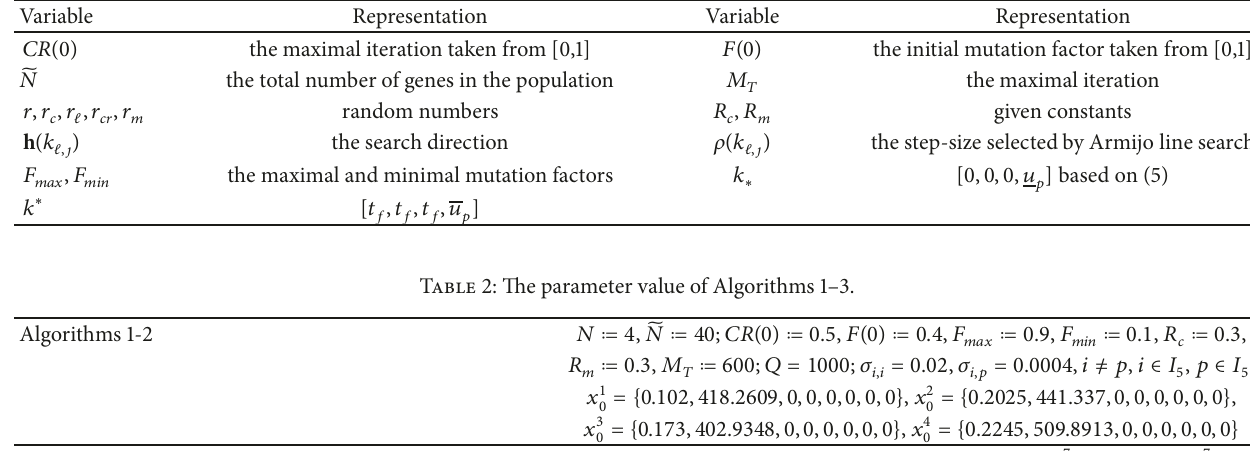
Table 3: The value of 𝑢 𝑖∗ 𝑝 , 𝜃 𝑖∗ , 𝑖 ∈ 𝐼 3 , 𝑡 ∗ 𝑓